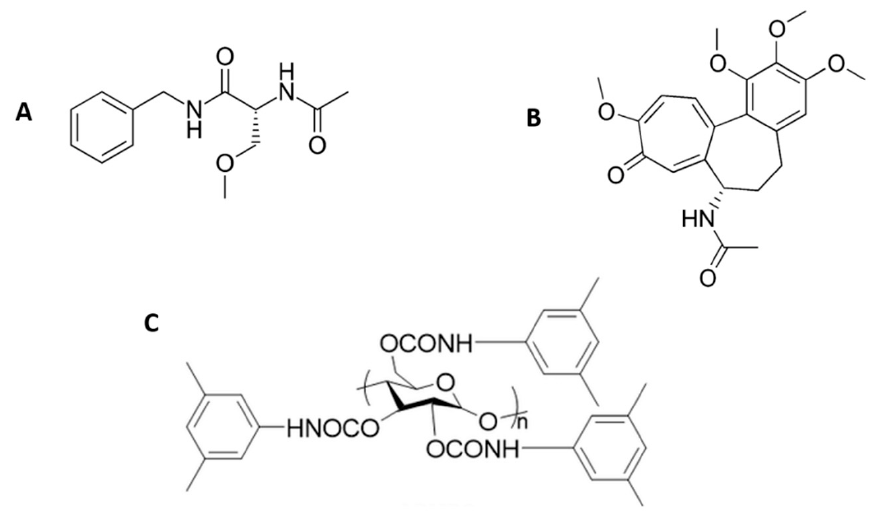
Figure 1. Chemical structure of ( A ) lacosamide, ( B ) colchicine, and ( C ) the amylose tris (3,5-dimethylphenylcarbamate) chiral stationary phase employed.